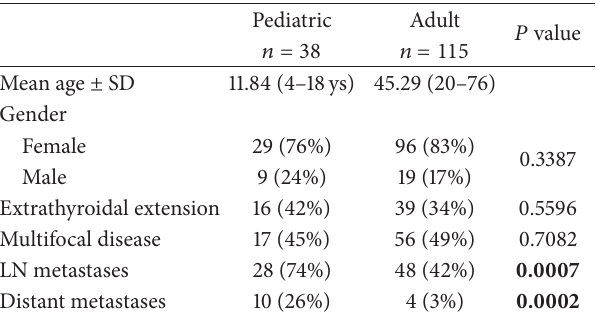
Table 2: Summary of the clinicopathological features of pediatric and adult thyroid